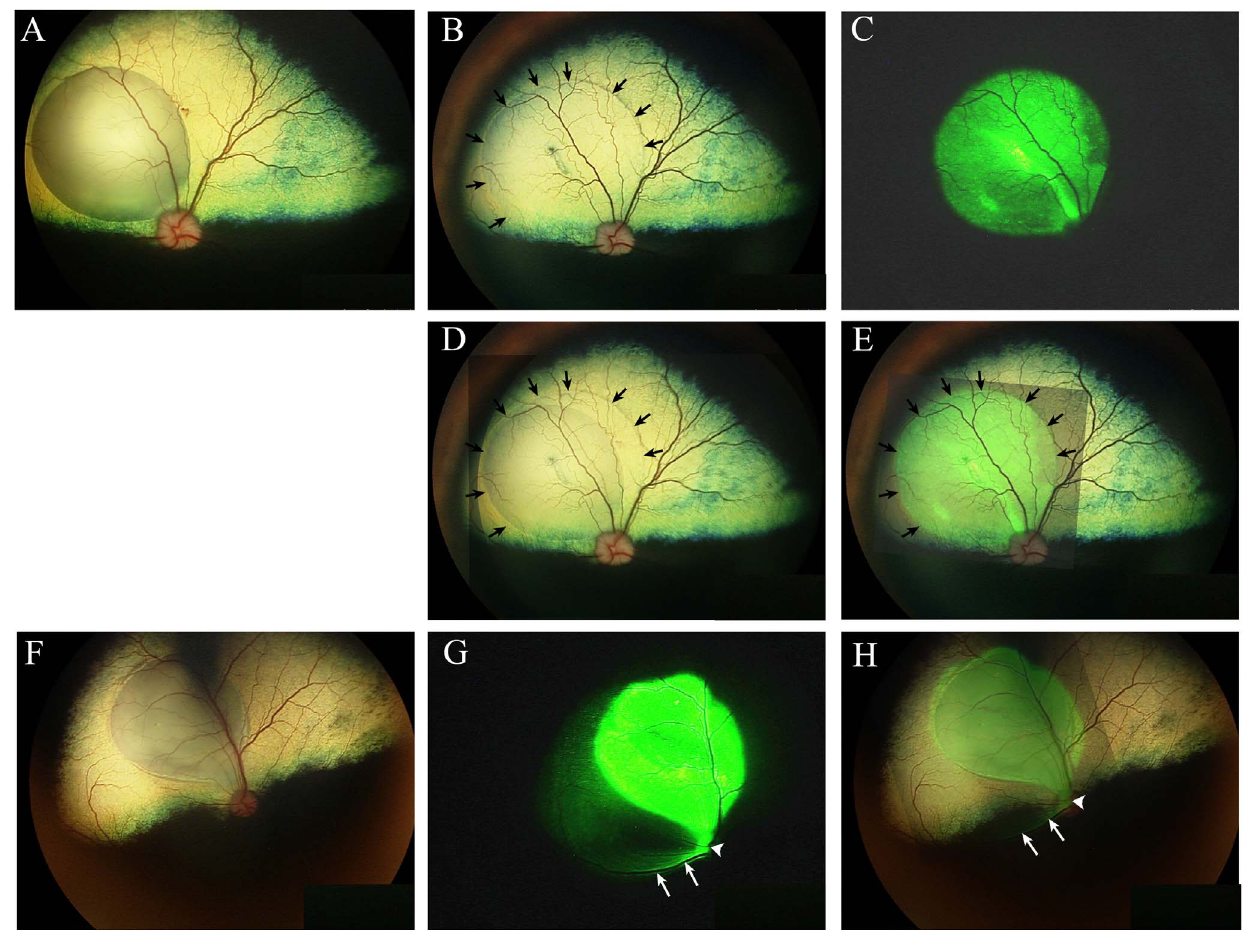
Figure 1. Color and fluorescent fundus images. A-E. Eye 7 OD (injected with scAAV8(Y733F)). F-G dog 5 OD (injected with scAAV5). A. The subretinal bleb of eye 7 OD immediately post-injection. B. The same eye as in A with arrows indicating the final boundary of the expanded subretinal bleb which is clearly visible in the fundus image. C. The same eye as in A showing in vivo GFP expression. D. A composite of image A and B to show expansion of the subretinal bleb prior to retinal reattachment (arrows are the same as in B). Note that the final boundary of the expanded subretinal bleb well beyond the initial boundary of the subretinal bleb immediately post-injection (an increase of 14.7% in size). E. A composite of images B and C. GFP expression is limited to the area delineated by the final boundary of the expanded subretinal bleb. F. The subretinal bleb of eye 5 OD immediately post-injection. G. The same eye as in F showing in vivo GFP expression. Arrows indicate regions of suspected nerve fiber layer GFP expression. The arrowhead indicates optic nerve head GFP expression. Note the retinal region medial to the subretinal bleb shows a pattern suggestive of GFP fluorescence within ganglion cell axons. Arrows indicate some of the stronger GFP expression in presumptive nerve fiber layer and the arrowhead indicates the GFP expression involving the optic nerve head. H. An overlay of images F and G. There is slight spread of GFP beyond the post-injection extent of the bleb. Arrows and arrowhead are as described for G.